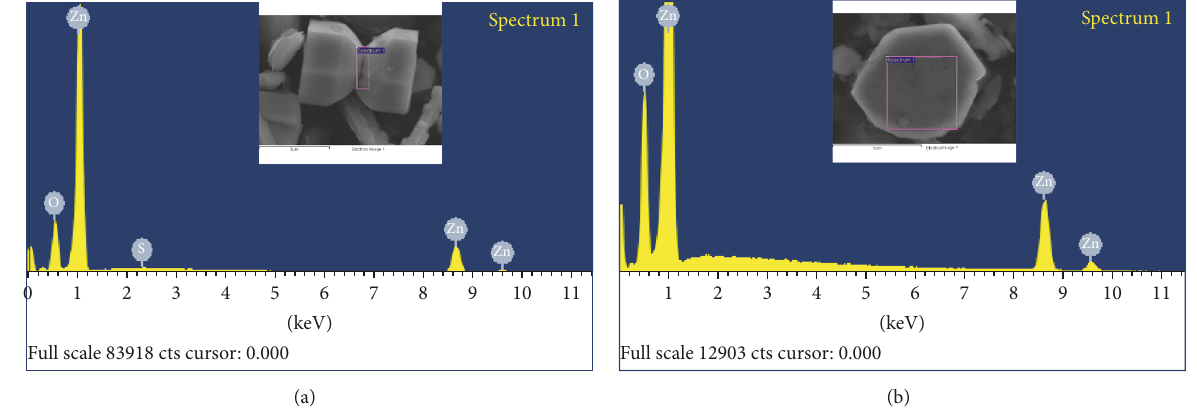
Figure 8: EDX spectra of ZnO nanodumbbells measured at different surfaces: (a) the twin junction and (b) basal plan of ZnO dumbbell.